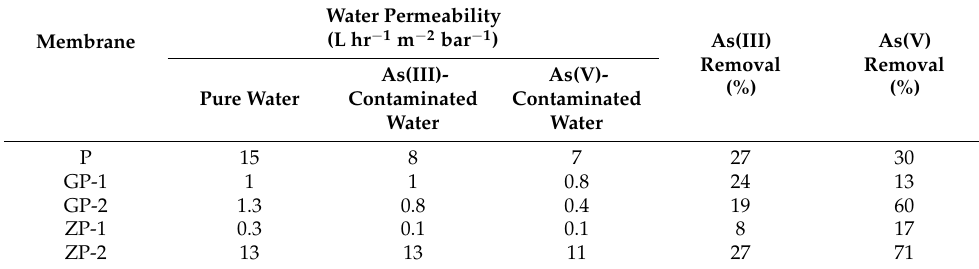
Table 6. Filtration performance of fabricated